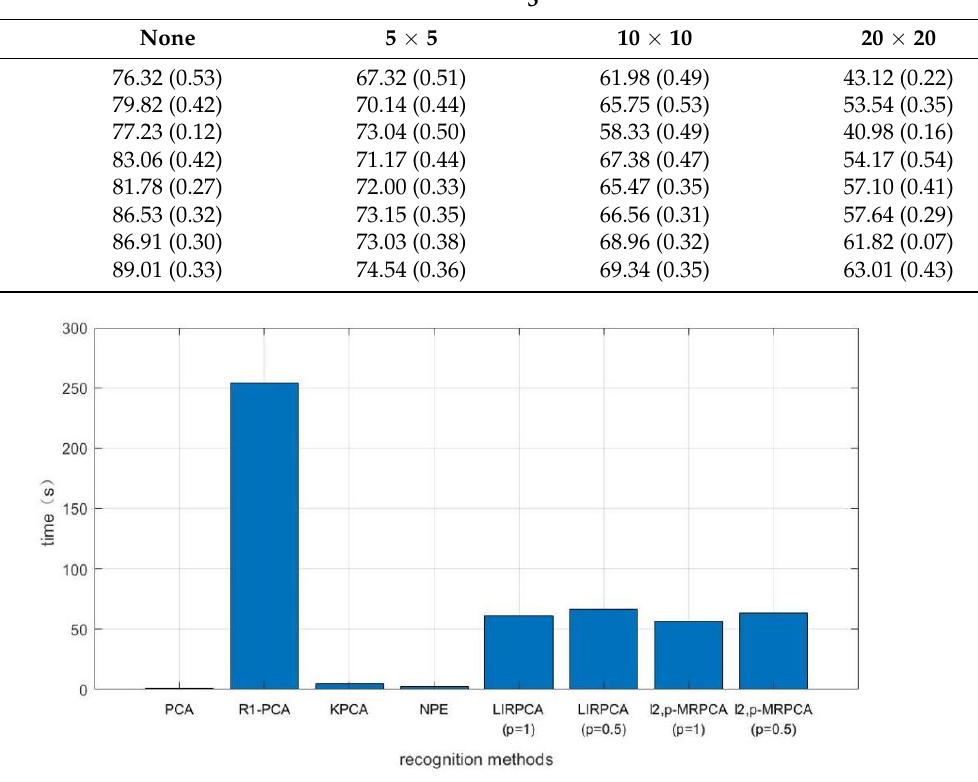
Figure 7. Classification recognition rate of PCA, 𝑅 1 -PCA, KPCA, NPE, LIRPCA ( 𝑝 = 0.5 ), LIRPCA ( 𝑝 = 1 ), 𝑙 2,𝑝 -MRPCA ( 𝑝 = 0.5 ), 𝑙 2,𝑝 -MRPCA ( 𝑝 = 1 ) on the PolyU palmprint database . 4.6. Result Analysis 1.